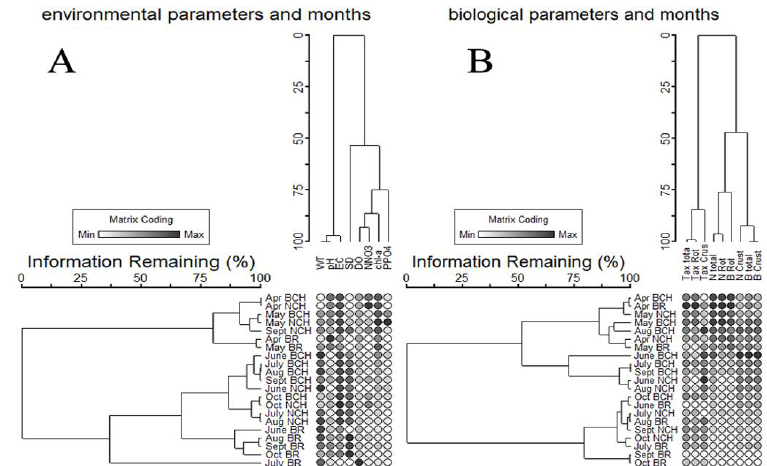
Figure 6. Tree diagrams of cluster analysis of study sites divided for seven months within vegetation season based on environmental parameters ( A ) and biological parameters ( B ) (zooplankton data) obtained using Ward’s method as linkage rule and Euclidean distances as the metric for distance calculation. BCH: Bydgoszcz Canal, NCH: Note´c Canal, BR: Brda River.